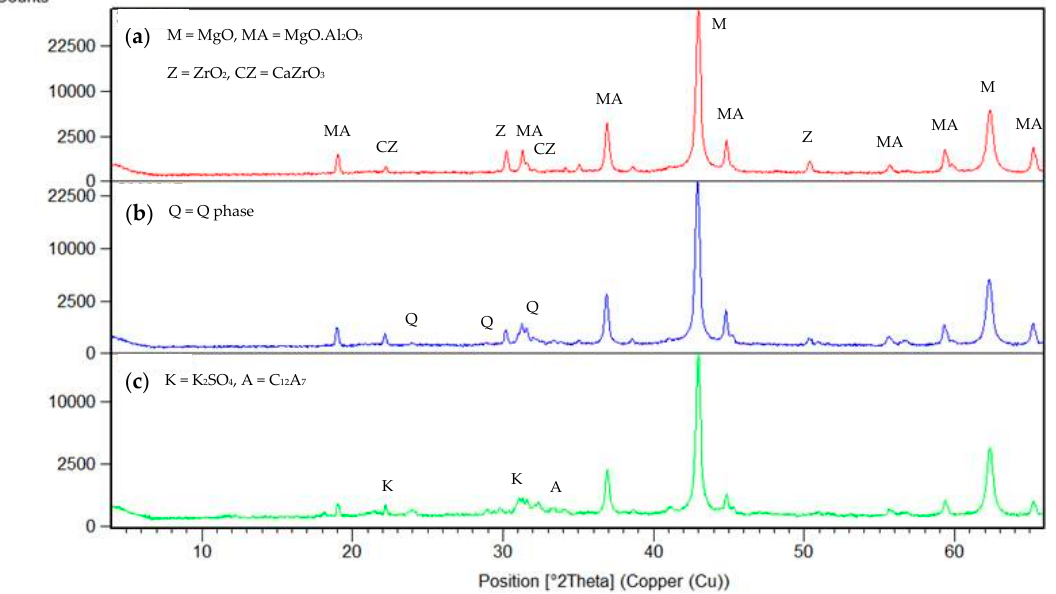
Figure 7. X-ray diffraction patterns of brick B. ( a ) Unused. ( b ) Hot face after contact coating test using